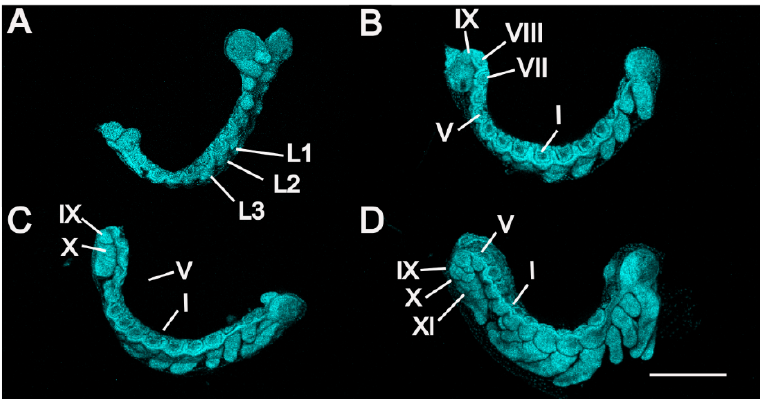
Figure 4. P. americana embryos in stages 5 to 8. Lateral views. Fluorescence images with DAPI- stained nuclei are shown. ( A ) Stage 5. ( B ) Stage 6. ( C ) Stage 7. ( D ) Stage 8. Scale bars: 500 μ m. L1–3,